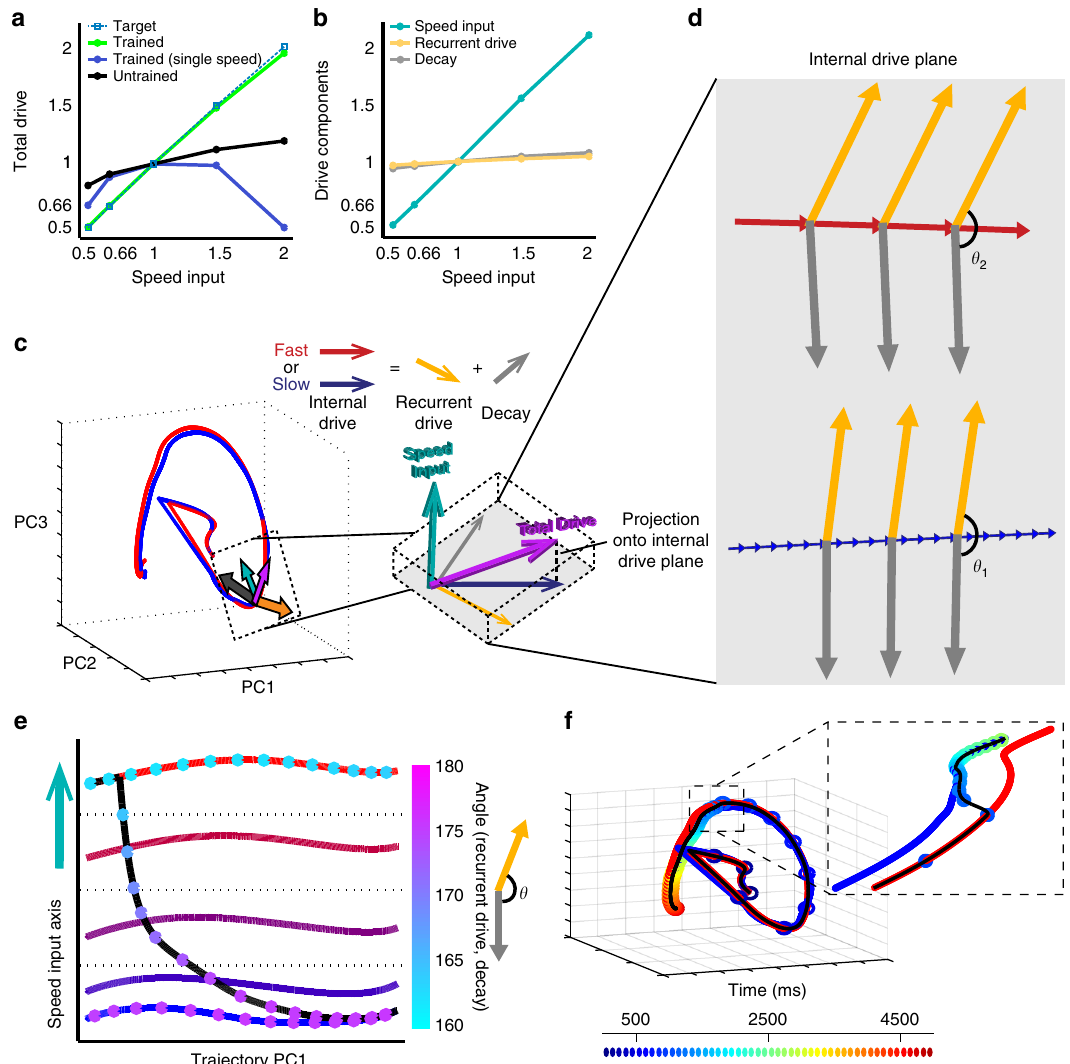
Fig. 8 Mechanisms of temporal scaling in the RNN. a Magnitude of the instantaneous change in activity (trajectory speed) of the recurrent network (total drive) scales linearly with speed input value in networks trained at two speeds (green), but not in networks trained at one speed or untrained networks. Total drive is normalized to the 1× speed. b Decomposing network drive into its three components (recurrent, decay, and input) revealed that the recurrent and decay components do not individually scale with speed input, thus neither of them in isolation can account for temporal scaling. c To examine the relationship between the recurrent and decay components separate from the input drive, we projected them onto the internal drive plane, a subspace orthogonal to the speed input (Methods). d This projection revealed that at faster speeds the angle between the recurrent and decay components decreases, creating a second-order effect that drives the network activity along the trajectory more quickly. e Network activity projected onto the input axis and the fi rst principal component of network activity (the dimension which accounts for the largest amount of variance). The colored markers indicate the angle between the recurrent and decay components. The position along the input axis does not change as a function of time, indicating that speed is encoded by the position along the input axis. When the speed input level is abruptly decreased partway through the trajectory (black line), the network switches from fast to slow speeds via an increase in the angle between the recurrent and decay components. f Neural trajectories in the fi rst three principal components during a mid-trajectory change in speeds. As the dynamics transition from fast to slow (inset), the trajectory (black line) moves along a hyperplane de fi ned by the parallel trajectories shown in Fig.